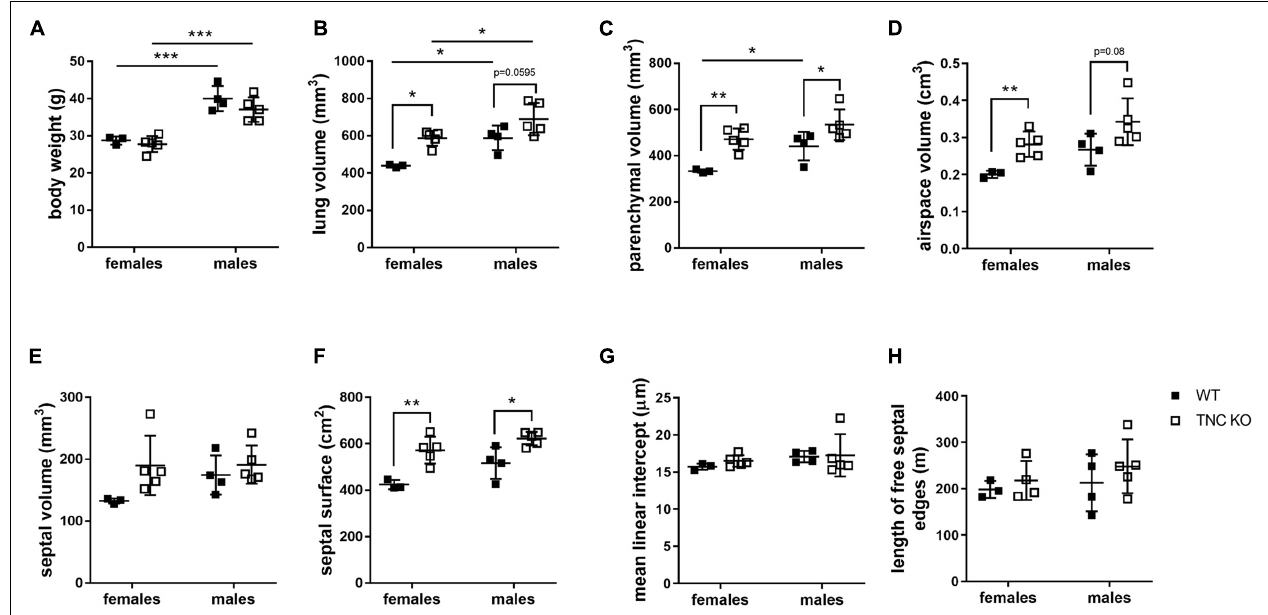
FIGURE 2 | Stereological analysis of old TNC-deficient and WT lungs. Stereological measurements were done on 5 µ m sections of 18 months old WT ( (cid:4) ) and TNC-deficient ( (cid:3) ) females and males lungs. (A) : body weight; (B) : lung volume; (C) : parenchymal volume; (D) : airspace volume; (E) : septal volume; (F) : septal surface area; (G) : mean linear intercept; (H) : total length of free septal edges. Each point represents one animal; WT: N = 3–4 animals/gender and TNC KO: N = 5 animals/gender. Results are expressed as mean ± SD. Statistical analysis was made by two-way ANOVA; statistical significance was set at p < 0.05; * p < 0.05, ** p < 0.01, *** p <